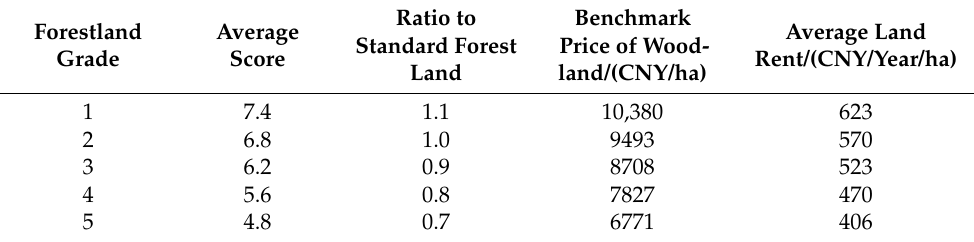
Table 4. Benchmark price of various forestland grades in Longquan